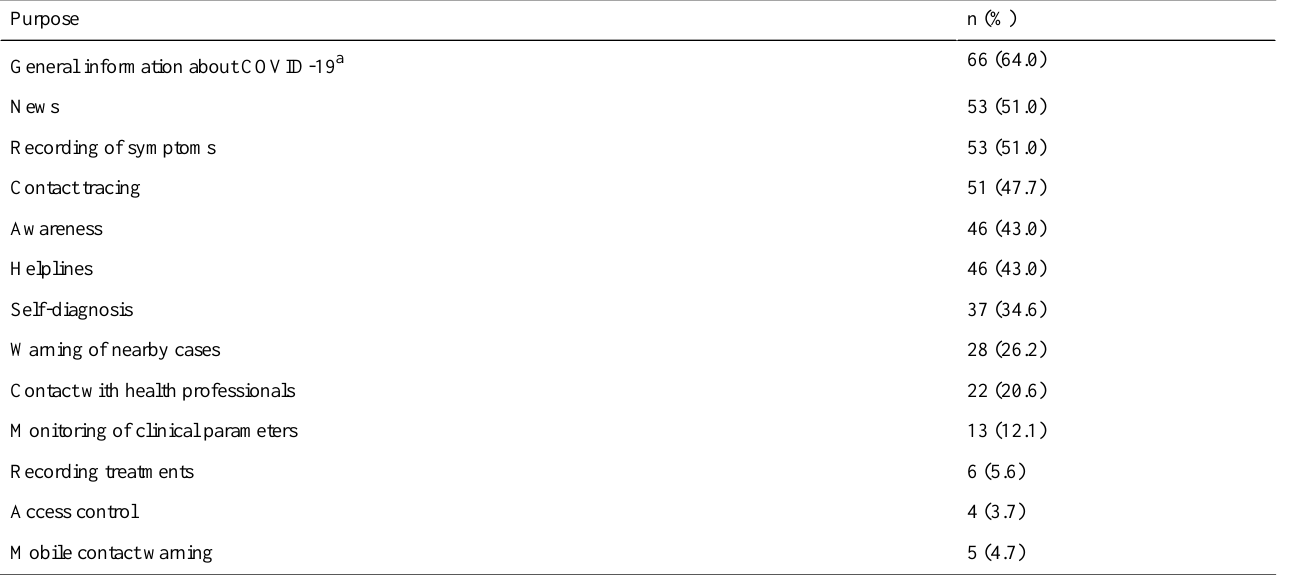
Table 3. Purposes of the apps